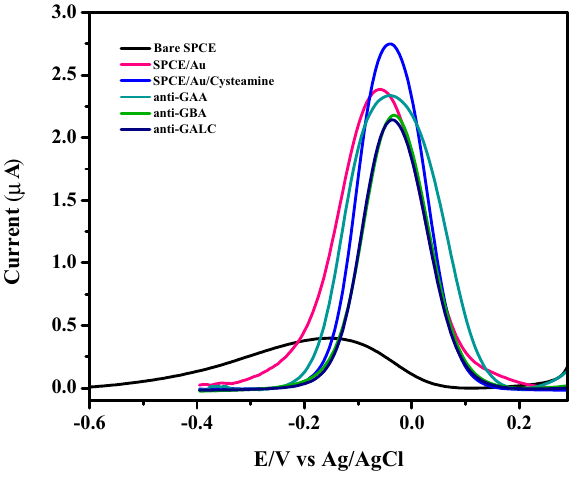
Figure 2. SWV peaks for the characterization of the fabrication steps of the immunosensor before, after AuNP electrodeposition and after immobilization of antibodies and blocking with